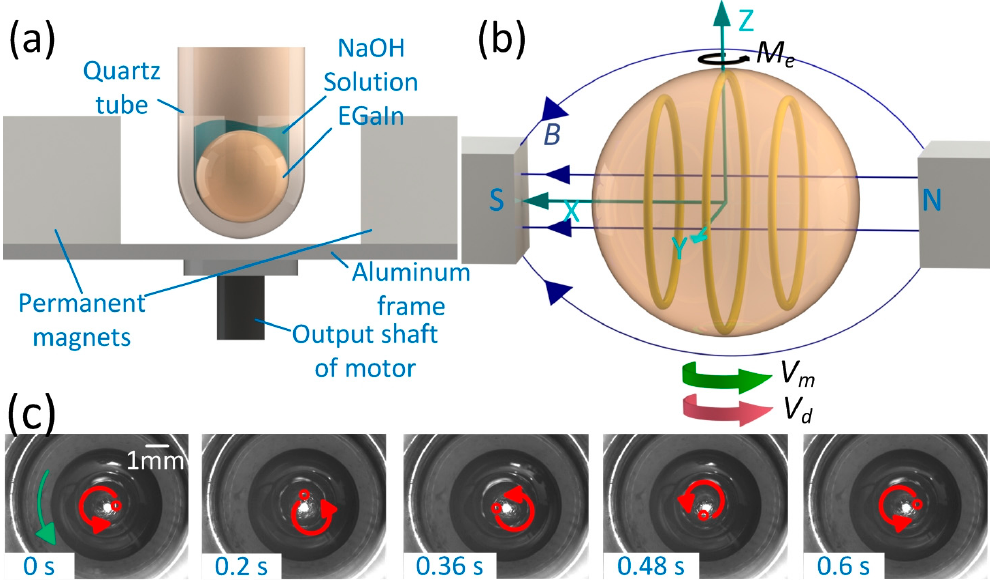
Figure 1. Self-rotation behavior of a liquid metal droplet (LMD). ( a ) Schematic of the self-rotation inducing setup. ( b ) Forces schematic of the equivalent coils in an EGaIn droplet; the magnetic field directions are indicated by the blue arrows, the magnetic field rotating direction (with a velocity of V m ) is indicated by the green arrow, the self-rotation direction of the EGaIn droplet (with a velocity of V d ) is indicated by the red arrow, and the forces experienced on the equivalent coils are indicated by the black arrows. ( c ) Continuous captures of the self-rotation of an EGaIn droplet (volume of 0.08 mL).